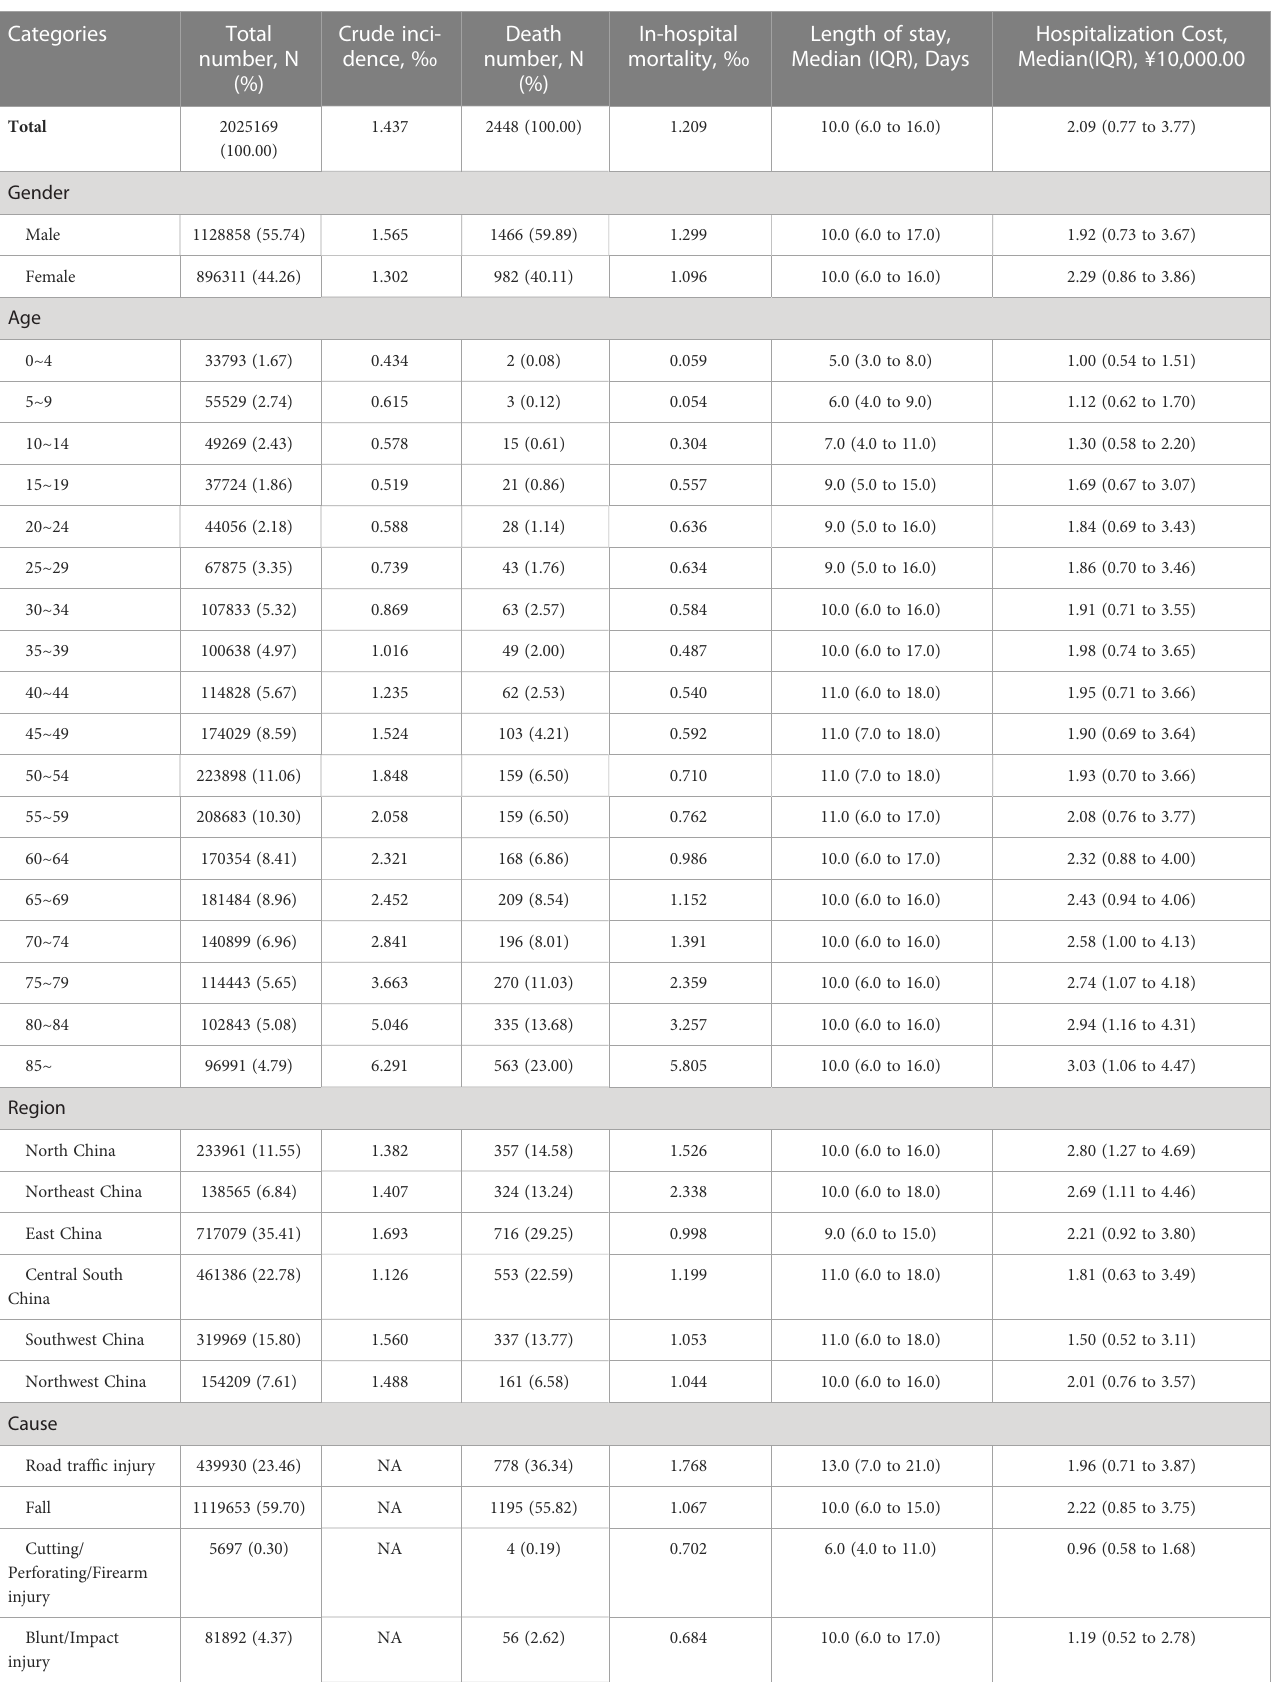
TABLE 1 A overview of the characteristics and the economic burden of inpatients with traumatic fractures in China in 2020.